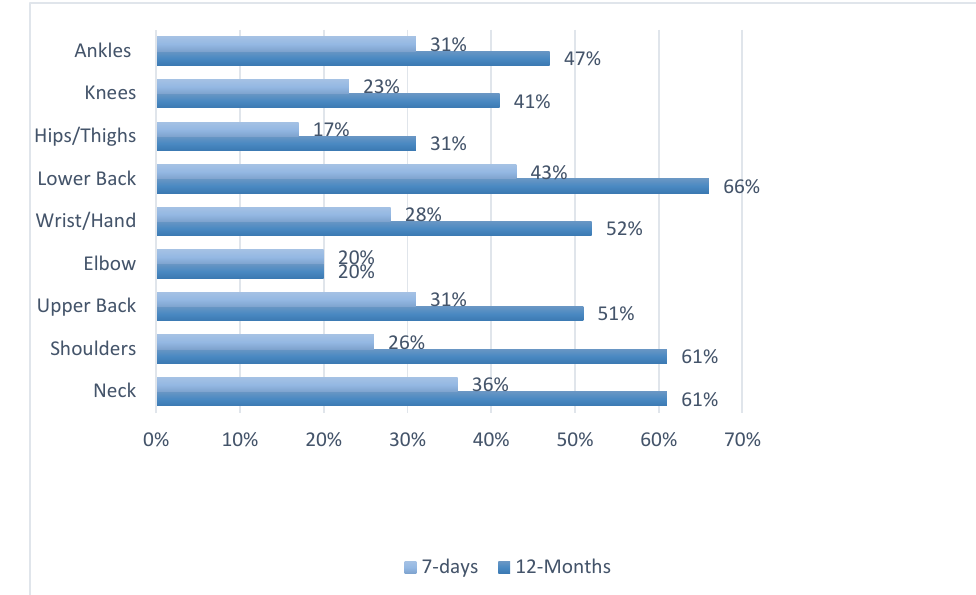
Figure 2. Prevalence of reported musculoskeletal disorder (MSD) symptom complaints in different body parts over 7-day and 12-month periods for all allied dental practitioner (ADP) occupations ( n = 355). Table 2. Prevalence of MSD symptoms for different body areas in the past 12 months for each ADP occupation ( n = 355). Occupation